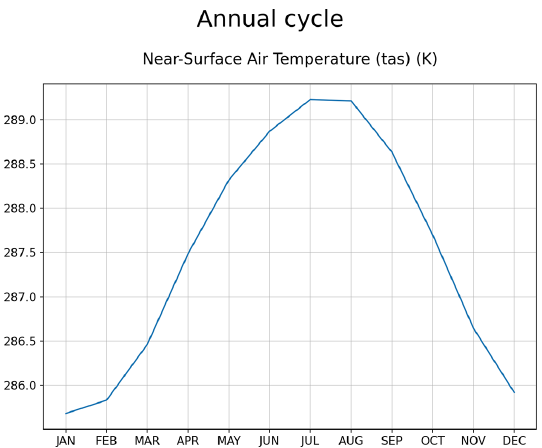
Figure 4. Annual cycle of the global mean near-surface air tem- perature from CESM2 averaged from 2005 to 2014. The CESM2 simulation shown here uses a standard AMIP setup with all forc- ings from the recent past and prescribed sea surface temperatures and sea ice